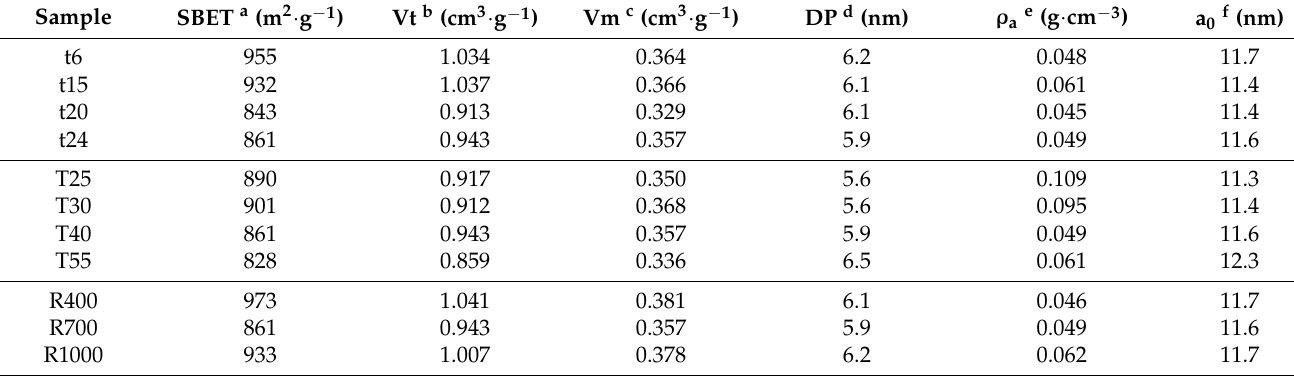
Table 1. Structural properties of the samples synthesized at different time, temperature, and stirring rate in the first step of the synthesis.